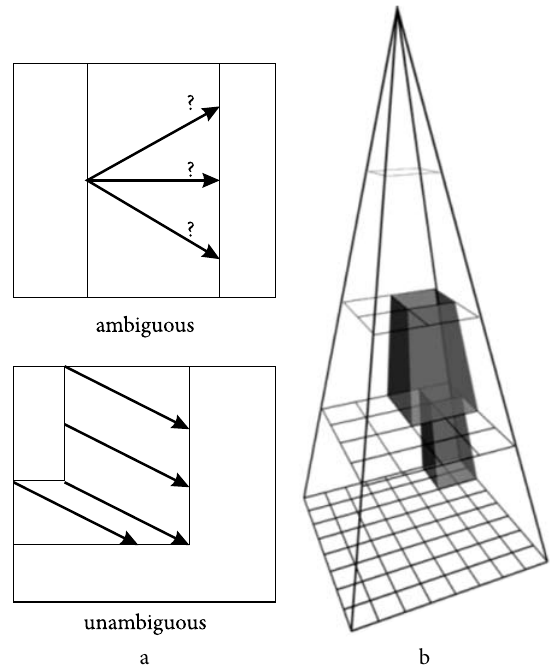
Fig. 11. Aperture problem (a), image pyramide (b)